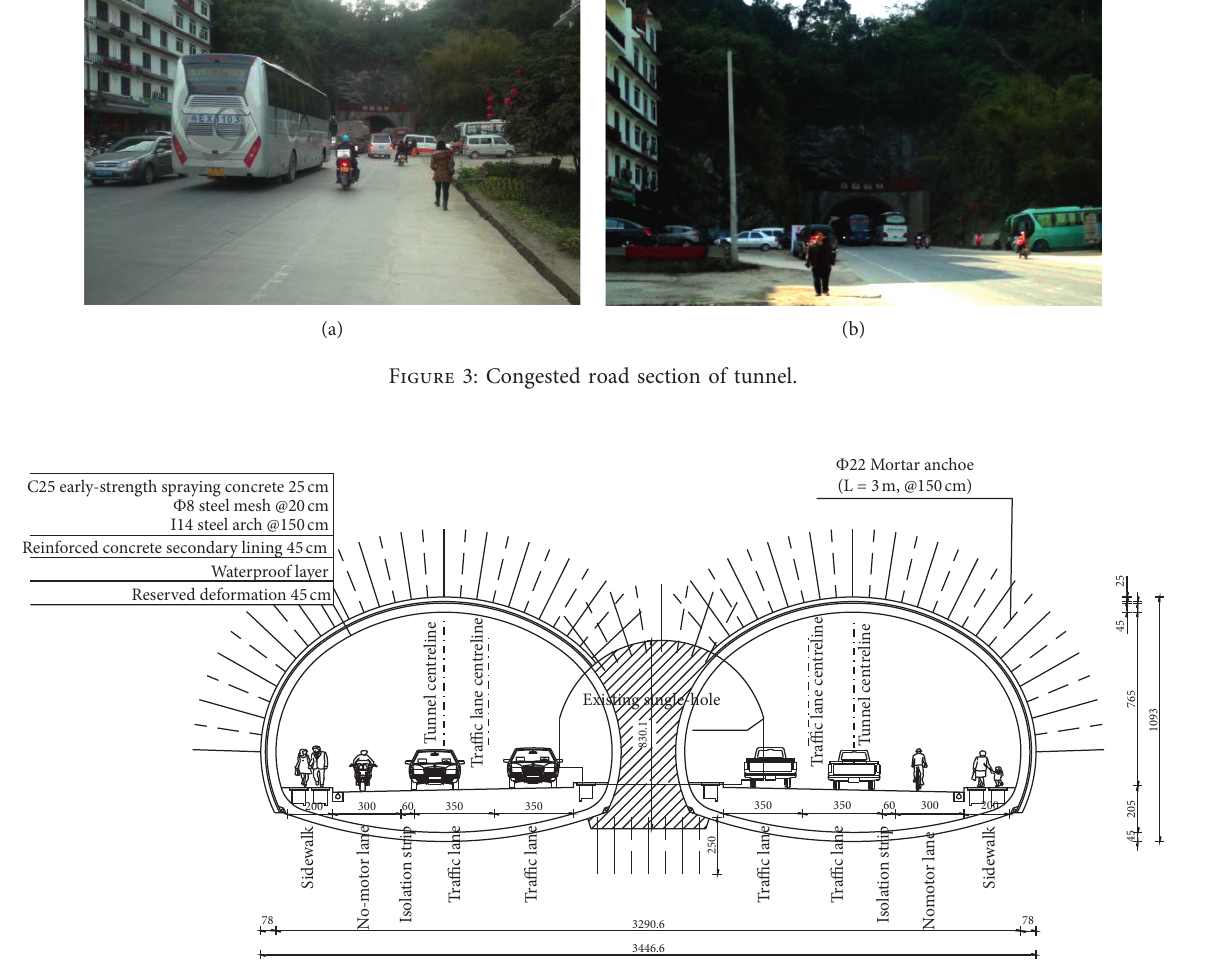
Figure 4: Cross section of reconstructed and expanded tunnel lining (unit: cm). Table 4: Tunnel support parameters (cm).